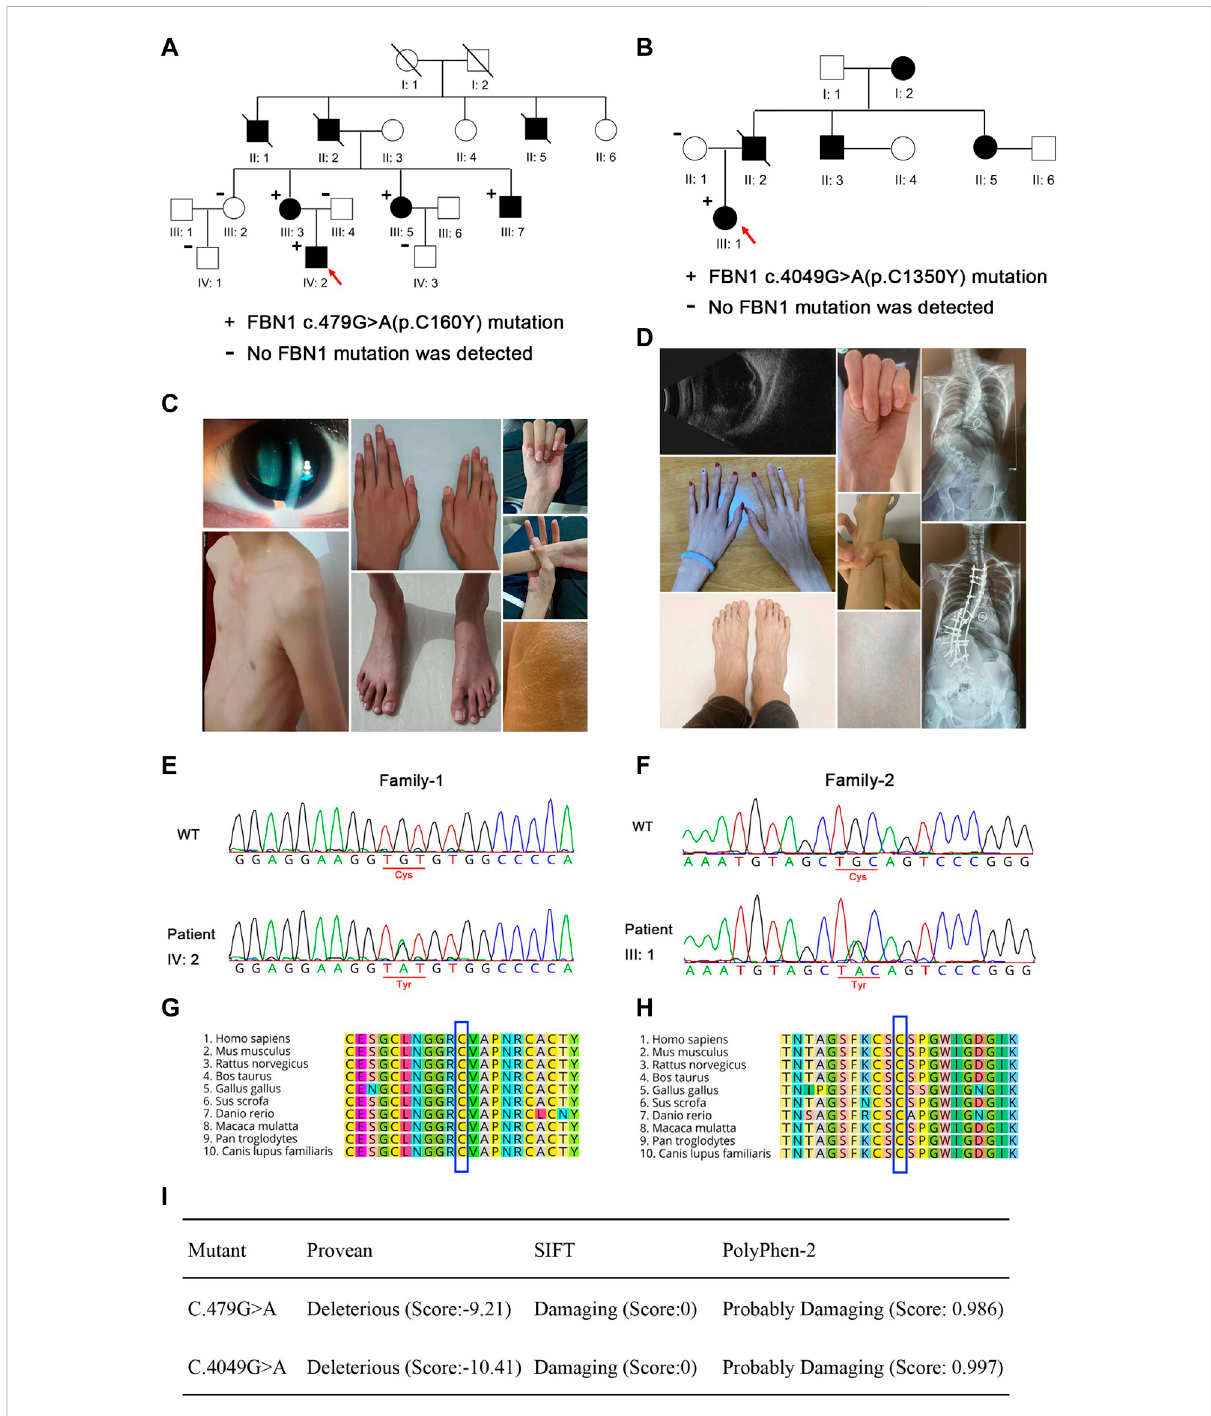
FIGURE 1 Pedigree and clinical characteristics of the two families. (A,B) Pedigree and clinical characteristics of family 1. (C,D) Pedigree and clinical characteristics of family 2. +, represents a heterozygous FBN1 mutation. - represents the unaffected members who were tested for the variants. The fi lled squares (male) and circles (female) indicate the individual had ectopia lentis and minor signs of Marfan syndrome. Red arrows indicate the probands. Representative sequencing results show the FBN1 c.479G > A (E) and c.4049G > A (F) mutations in the family members with Marfan syndrome and the corresponding sequence in the unaffected family members. Conservation analysis in multiple species for p. C160Y (G) and p. C1350Y (H) . (I) Pathogenicity prediction of FBN1